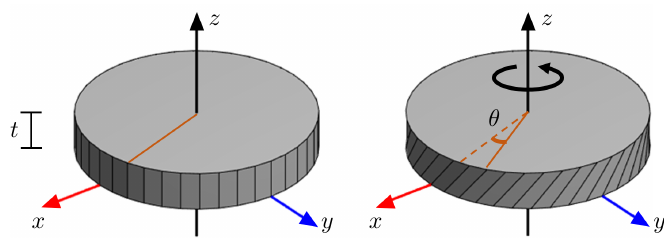
Figure 1. Considered disc during finite element simulations. Making use of cylindrical coordinates M Figure 1: Each material point M x in macrocontinuum M corresponds to a microstructure of ∈ B B B ( r , ψ , z ) with x = r cos ψ , y = r cos ψ , during loading bottom surface with z = 0 is fixed completely the representative volume whose effective behavior is representative of that of the material as a whole. V Here, M denotes the characteristic size of the body at macroscale or the length scale associated with with u r ( r , ψ ,0 ) = u ψ ( r , ψ ,0 ) = u z ( r , ψ ,0 ) = 0 whereas at the top surface with z = t , torsional loading L the fluctuations of the applied mechanical loading. RVE is the RVE size. Computationally, different L along z -axis is applied with u r ( r , ψ , t ) = 0, u ψ ( r , ψ , t ) = θ and u z ( r , ψ , t ) = 0. The shear strain, ε ψ z , discretization strategies are possible in the representation of the domain, e.g., a voxel-FE or beam-FE model, as used in the current work. is kept constant for different radii of discs by scaling the thickness with the radius as: t = 0.24 r